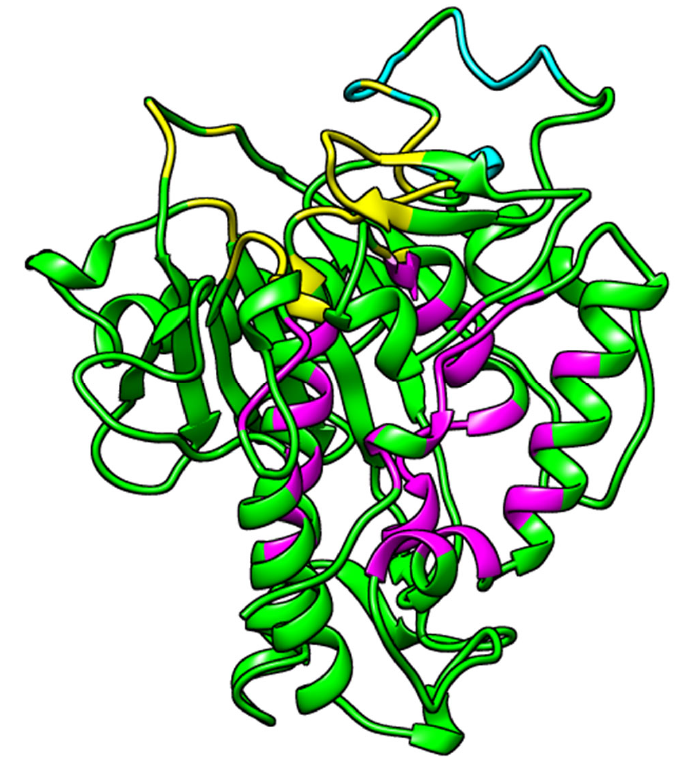
Figure 2. 3D structure of ADAR2 (PDB ID 5ED2) showing the predicted binding sites. Predicted binding sites are colored yellow, magenta and cyan for pockets 1, 2 and 3, respectively. Image was generated using UCSF Chimera version 1.16 [42].